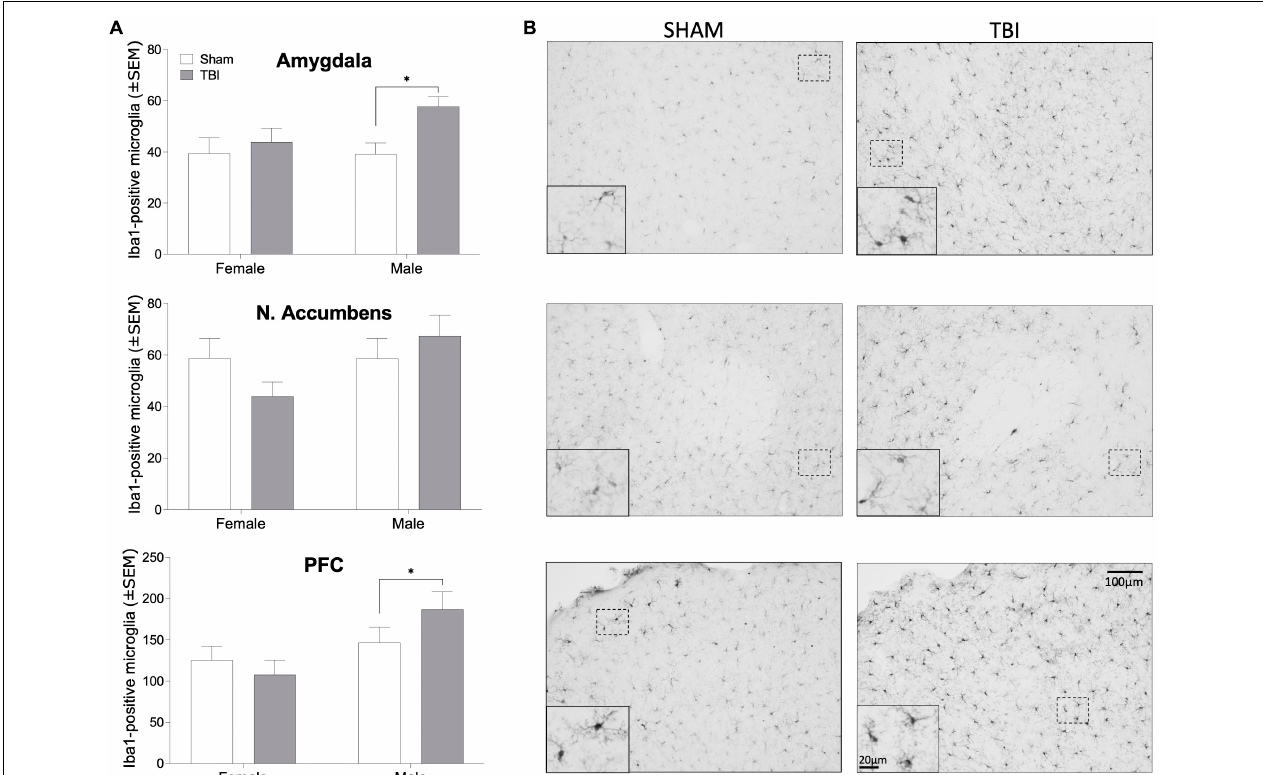
FIGURE 4 | Iba1-positive microglia. (A) Bar graphs depicting mean ( ± SEM) microglial cell counts per mm 2 in brain regions important for alcohol reward in male and female mice. (B) representative photomicrographs of Iba1 immunohistochemistry in male mice. An asterisk ( ∗ ) indicates significant main effect of injury, ANOVA p < 0.05. Scale bar = 100 µ m, inset scale bar = 20 µ